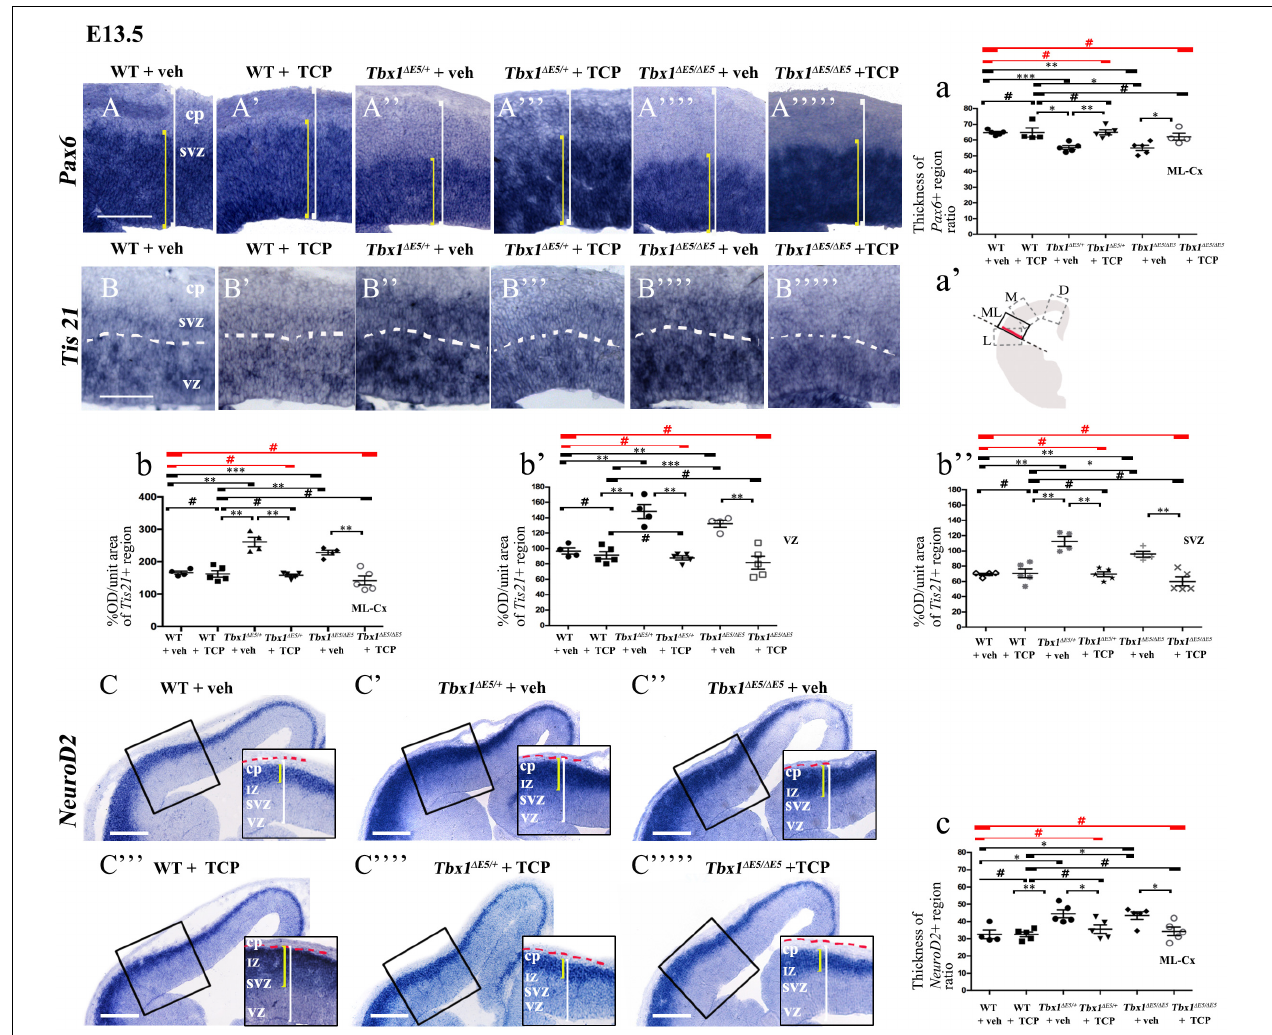
FIGURE 1 | TCP treatment restores normal expression of cortical markers in Tbx1 mutant embryos. Panels show coronal sections of embryonic brains at E13.5. The cartoon a’ indicates the position of the ML-cortex in coronal brain sections (boxed area). The red line indicates the position where all measurements were made. (A,a) In situ hybridization of Pax6 (A–A””’) revealed thinning of the expression domain (yellow brackets) in vehicle-treated Tbx1 (cid:49) E 5 / + (heterozygous) embryos (A”) and Tbx1 (cid:49) E 5 /(cid:49) E 5 (homozygous) embryos (A””) compared to vehicle-treated WT embryos (A,a) , which was rescued by TCP treatment (A”’,A””’,a) . (B,b) In situ hybridization of Tis21 (B–B””’) showed increased expression (OD) in the ML-cortex of vehicle-treated Tbx1 (cid:49) E 5 / + embryos (B”,b) and Tbx1 (cid:49) E 5 /(cid:49) E 5 embryos (B””,b) , compared to vehicle-treated WT embryos (B,b) , including the VZ (b’) and SVZ (b”) , which was rescued by TCP treatment (B”’,B””’, b,b’,b”) . (C,c) In situ hybridization of NeuroD2 (C–C””’) showed increased expression in the ML-cortex of vehicle-treated Tbx1 (cid:49) E 5 / + embryos (C’,c) and Tbx1 (cid:49) E 5 /(cid:49) E 5 embryos (C”,c) compared to vehicle-treated WT embryos (C,c) , and extension of the expression domain (yellow brackets in C’,C” ) relative to the total ventricular pial thickness (white brackets), which was rescued by TCP treatment (C””,C””’,c) . Scale bars, 100 µ m in all panels except panel C, which is 200 µ m. * P ≤ 0.05, ** P ≤ 0.01, *** P ≤ 0.001, error bars indicate mean ± SD, red horizontal bars with # not significant, n = 5–6 per genotype. VZ, ventricular zone; SVZ, subventricular zone; IZ, intermediate zone; CP, cortical plate; ML-Cx, medio-lateral cortex; D, dorsal; M, medial; ML, medio-lateral; L, lateral; OD, optical